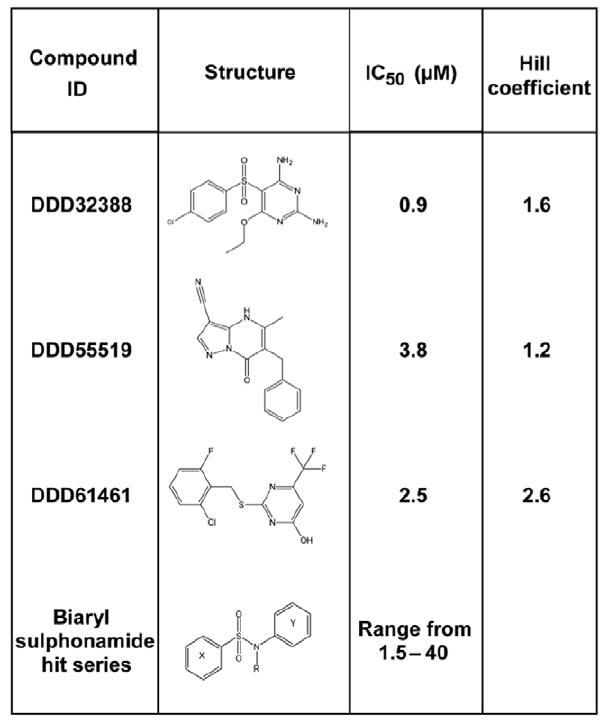
Figure 7. Confirmed hit compounds from hit discovery campaign. Summary of the compounds and series identified through the HTS and their respective potencies and Hill slope values.